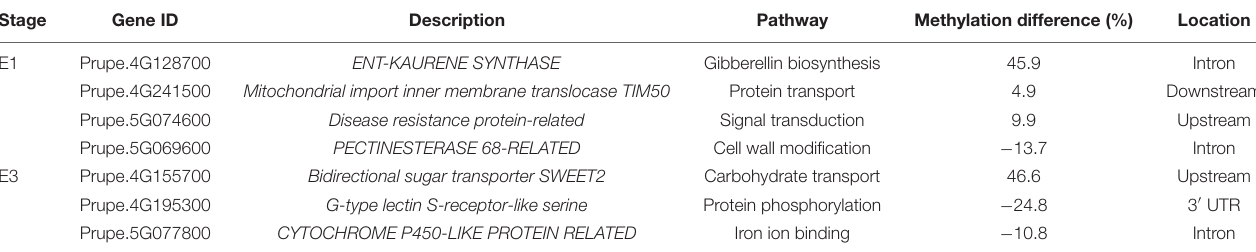
FIGURE 2 | DNA methylation levels across the eight pseudomolecules of P. Persica. (A) Methylation levels considering all cytosine contexts in normal fruits (blue line) and mealy fruits (green line). Horizontal green bars represent the location of previously identified QTLs for mealiness, while dashed vertical lines indicates the approximate location of centromeres. (B) Methylation levels in CpG, CHG, and CHH contexts within chromosome 4, the main candidate associated with mealiness phenotype based on QTL studies. TABLE 2 | Genes that co-localized with QTLs for mealiness within chromosomes 4 and 5 and presented differentially methylated regions (DMRs) between mealy and normal fruits at E1 and E3